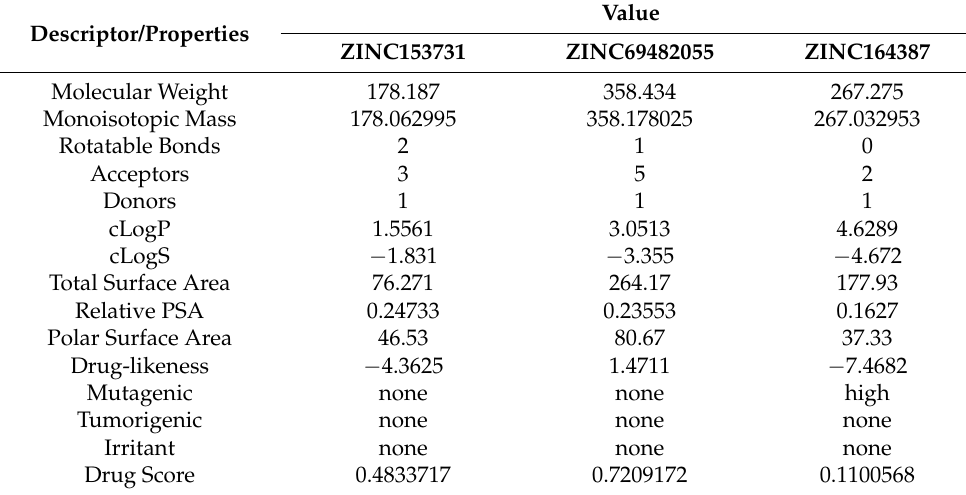
Table 1. Physicochemical and drug-like properties analysis.